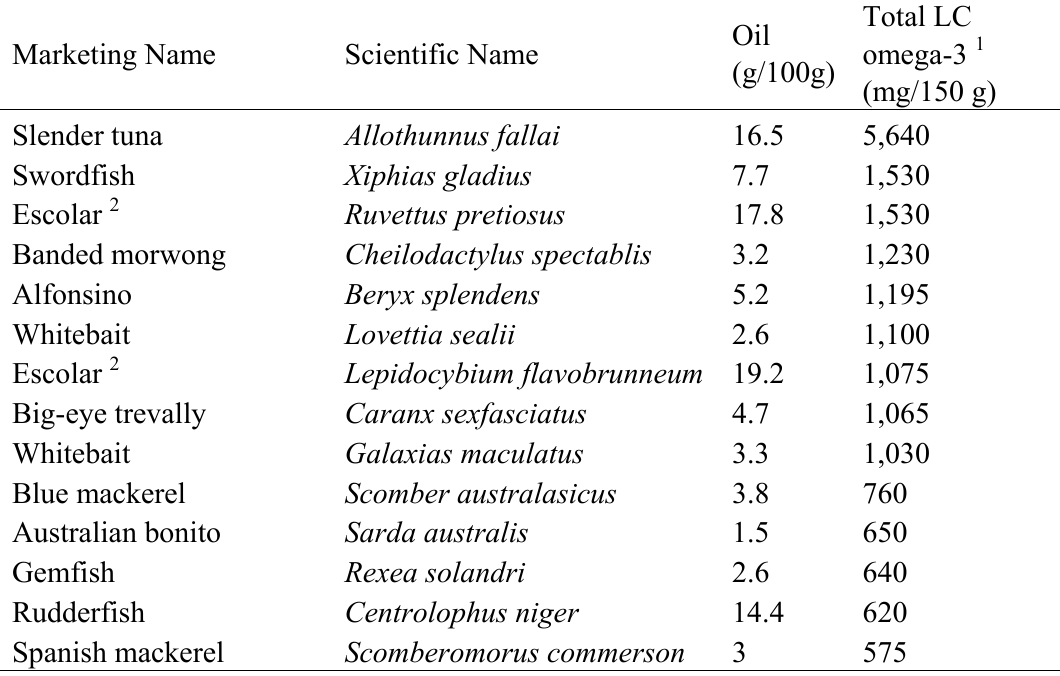
Table 2. Wild-caught Australian seafood containing more than 450 mg/150 g (raw) of LC omega-3, data derived from